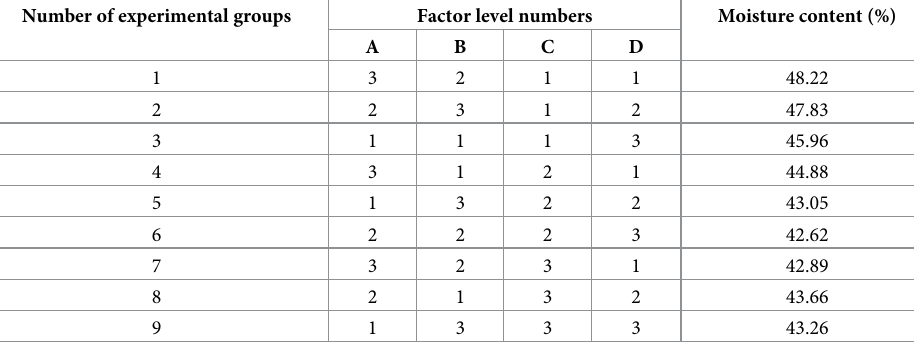
Table 3. Orthogonal experimental results of OSM